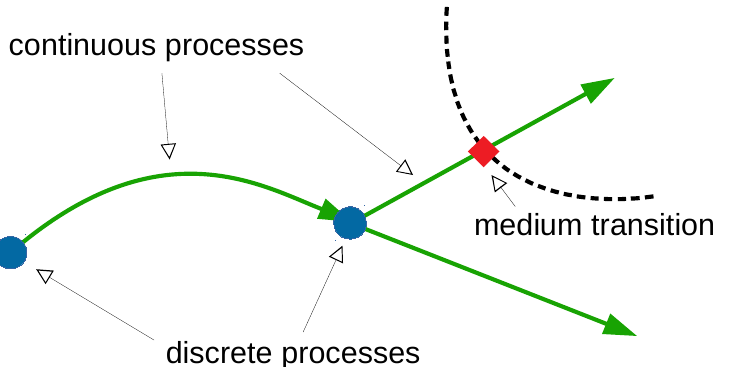
Figure 2. Discrete (blue dots) and continuous (green lines) processes during particle transport. The sampled random locations of dis- crete processes, which can be interactions, decays or boundary crossings (red square), determines the regime for continuous